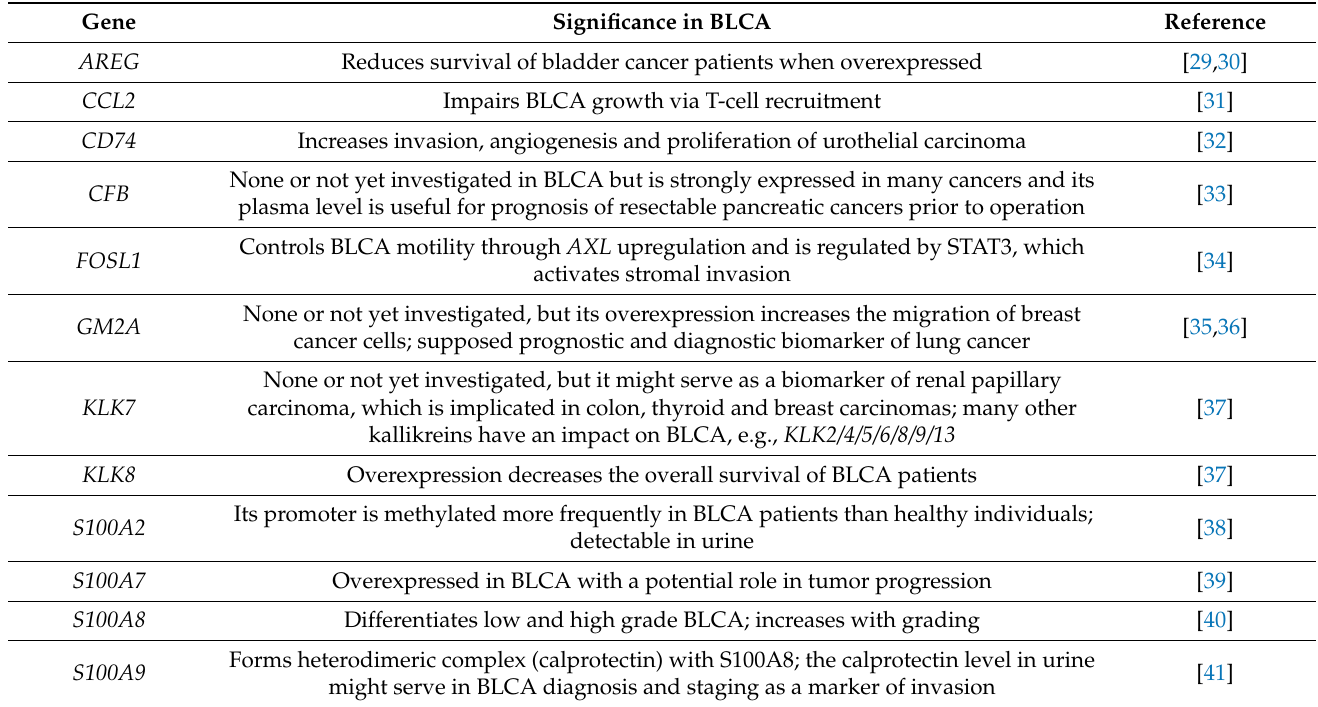
Table 1. Significance of the most frequent and interacting DEGs regarding bladder